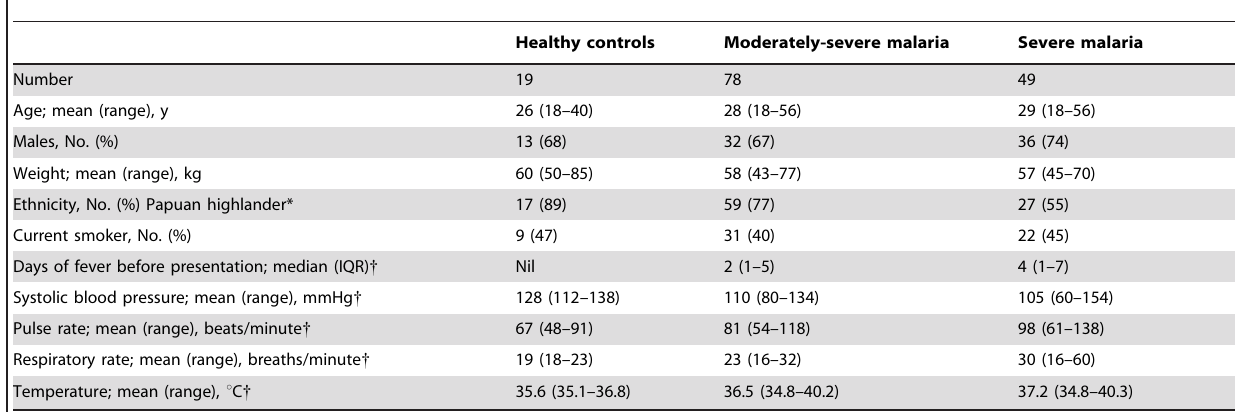
Table 1. Baseline Characteristics of Patients According to Clinical